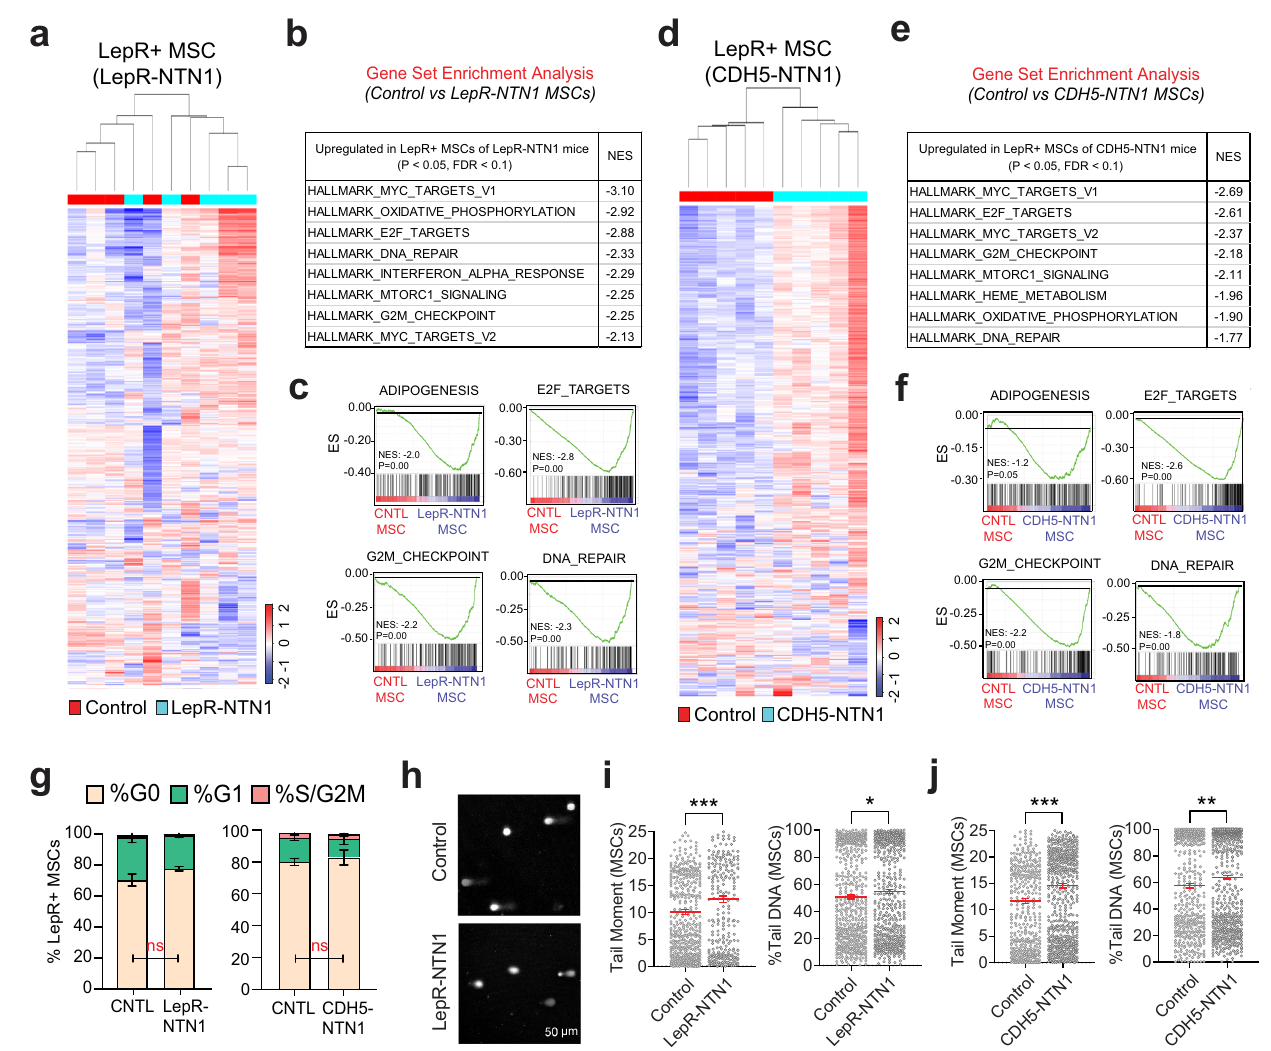
Fig. 4 | Loss of NTN1 causes DNA damage within LepR+MSCs. a – c RNA-Seq analysis of LepR+ MSCs derived from young (5-6 month-old) LepR-NTN1 mice. a Heatmapdepictinghierarchicalclusteringofdifferentiallyexpressedgenes. b GSEA demonstrating activation of DDR pathways in LepR+ cells of LepR-NTN1 mice. c GSEA Enrichment plots demonstrating activation of ADIPOGENESIS and DNA REPAIR pathwaysinLepR+cellsof LepR-NTN1 mice. d – f RNA-SeqanalysisofLepR+ MSCs derived from CDH5-NTN1 mice. d Heatmap depicting hierarchical clustering of differentially expressed genes. e GSEA demonstrating activation of DDR path- ways in LepR+ cells of CDH5-NTN1 mice. f GSEA Enrichment plots demonstrating activation of ADIPOGENESIS and DNA REPAIR pathways in LepR+ cells of